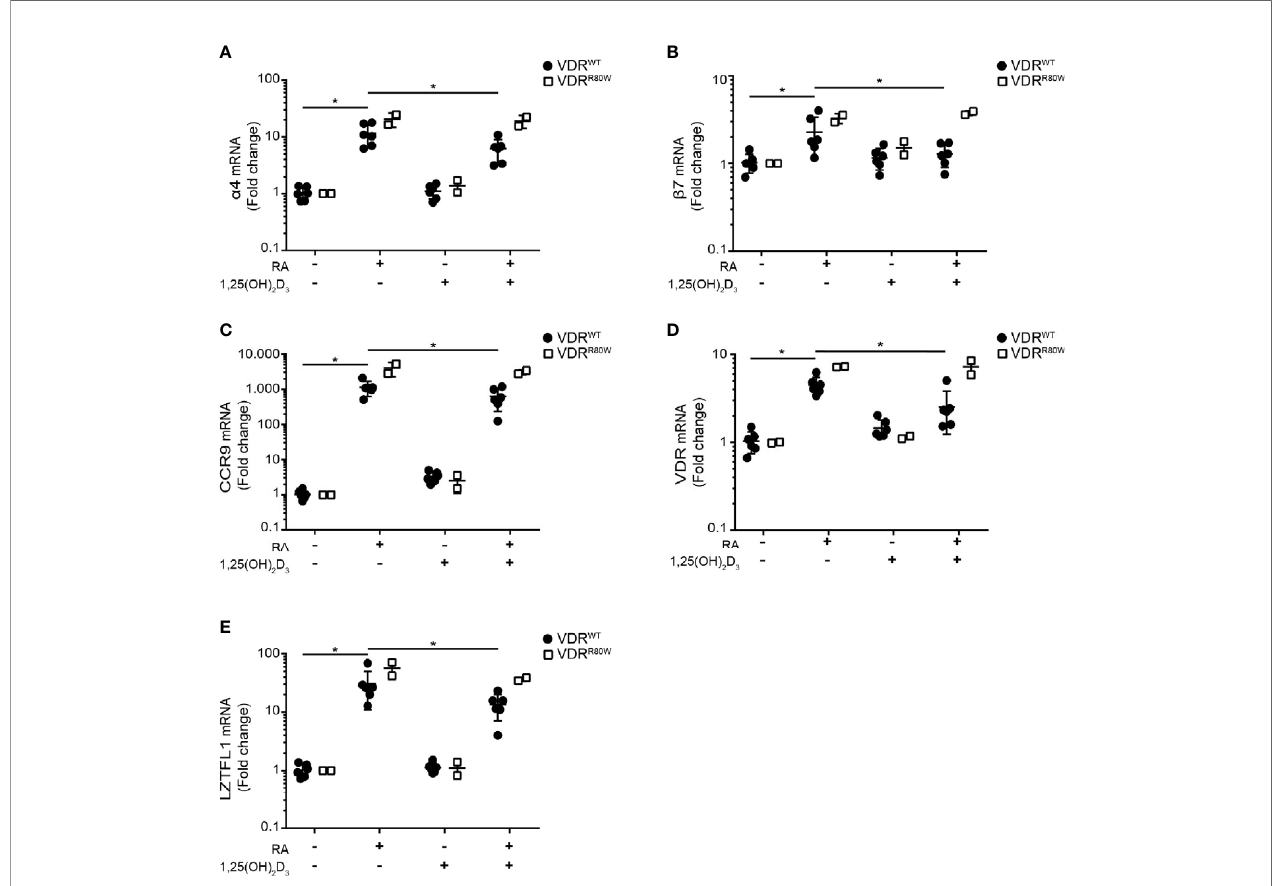
FIGURE 5 | The R80W mutation abolishes 1,25(OH) 2 D 3 -mediated suppression of RA-induced gene up-regulation Relative mRNA expression of (A) a 4, (B) b 7, (C) CCR9, (D) VDR and (E) LZTFL1 in VDR WT (black circles) and VDR R80W (white squares) CD4 + T cells activated in the absence (-) or presence (+) of RA (1 µM) and 1,25(OH) 2 D 3 (10 nM). The expression levels are given as fold change normalized to the average expression level of the target gene in each group activated in the absence of RA and 1,25(OH) 2 D 3 . Mean ± SD (VDR WT n = 6; VDR R80W n = 1 repeated twice; *p <